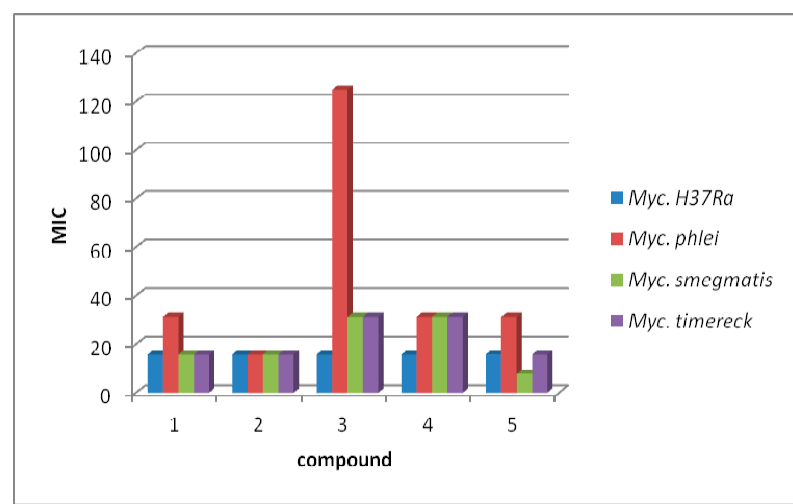
Figure 2. Antimycobacterial activity of active compounds.